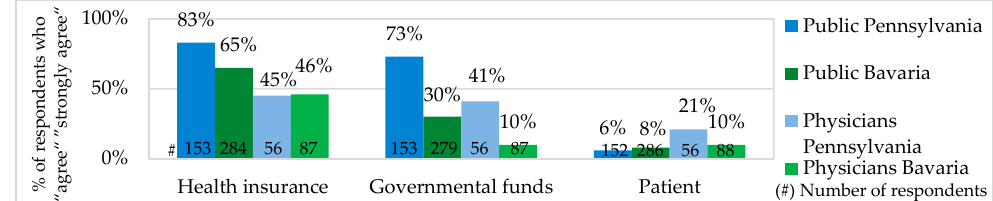
Figure 7. Healthcare Stakeholder Responsible to Cover Personalized Medicine Costs.